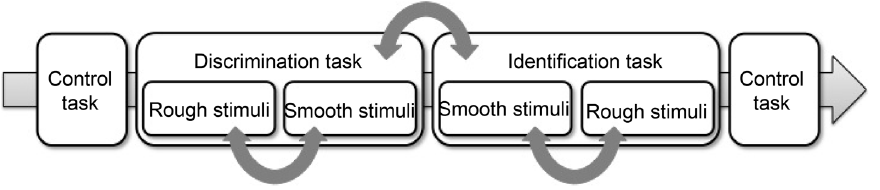
Figure 3. Order of conditions in the experiment. Curved arrows indicate parts to be randomized over participants.